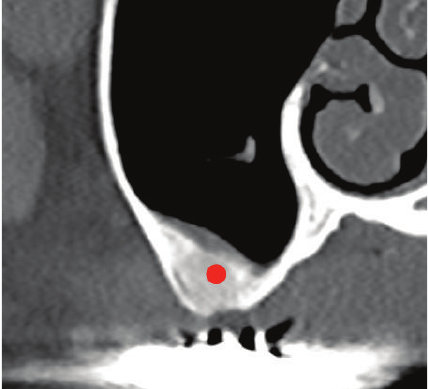
Figure 3: A biopsy was harvested from the red dot, which indicates the site of newly formed tissue (Case 1).